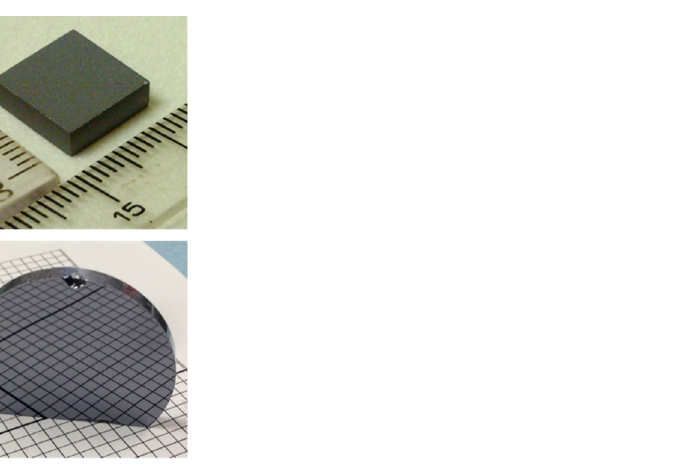
9 of 23 Figure 6. Powder X-ray diffractogram ( a ) survey scan using XPS ( b ) and EDX scan. (Adapted with permission from ref. [49]. Copyright 2021, IEEE) ( c ) of Cd 0.9 Zn 0.1 Te 0.97 Se 0.03 grown using a VBM growth at U of SC. Figure 7. Cross-sectional view of a Cd 0.9 Zn 0.1 Te 0.97 Se 0.02 ingot grown using a VBM method at U of SC. The grain boundaries have been emphasized with white lines for ease of visualization. The lapping and polishing are generally done by hand as CZTS crystals are brittle and often of non-standard shapes and sizes to fit in standard machine chucks. The pol- ished wafers are then thoroughly cleaned using deionized water to clean off any residual alumina powder. The cleaned wafers are chemo-mechanically polished by dipping the wafers in a 1–2% bromine-methanol (Br 2 -MeOH) solution for a few minutes (typically 1 min for a 2% Br 2 -MeOH solution) to minimize the surface defects caused by crystal cutting and polishing [50]. The chemo-mechanical polishing gives a very smooth texture to